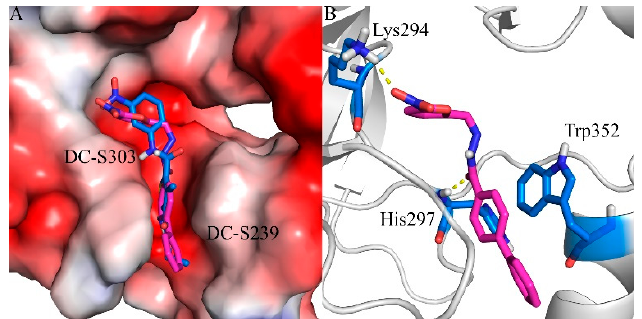
Figure 6. Predicted binding mode of DC-S303 against SET7. ( A ) Binding conformation alignment of DC-S303 and DC-S239. All the compounds are shown in sticks and the protein is shown in surface; ( B ) Putative binging mode of DC-S239 and important polar interactions. The compound is shown in magentas sticks and key residues are displayed in blue sticks.